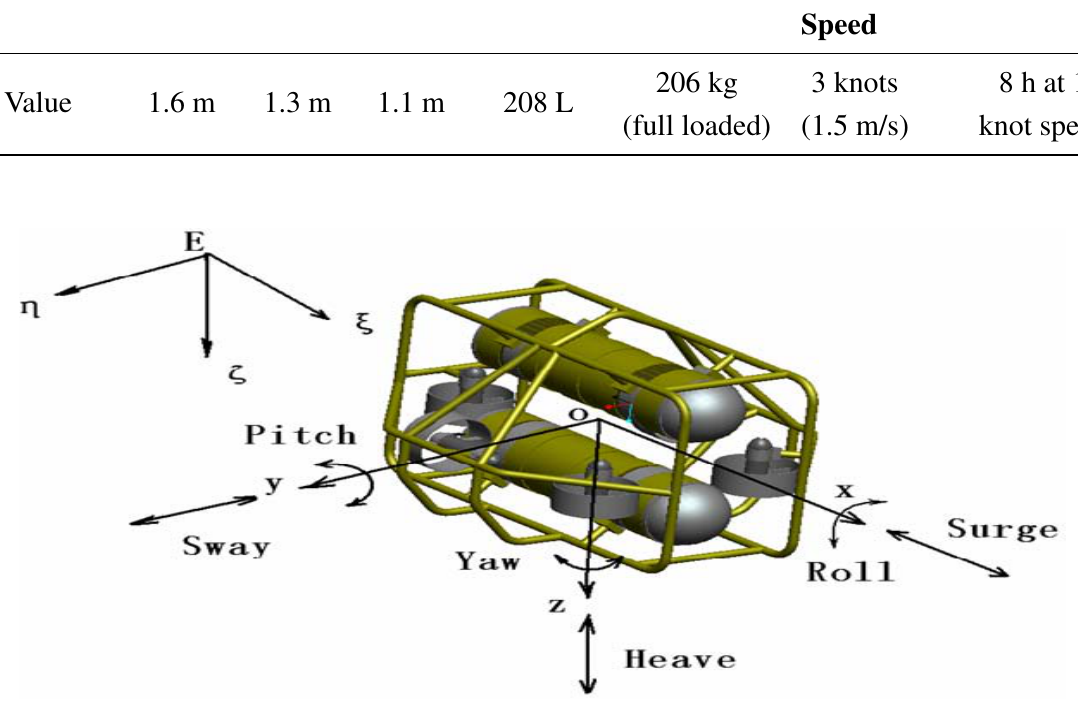
Figure 12. The coordinate system of the C-Ranger